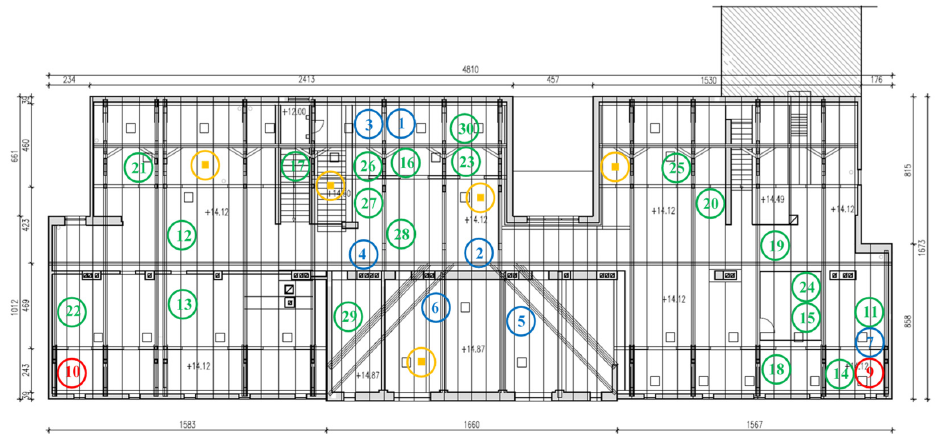
Figure 14. Probe positions and positions of damaged elements are shown in the construction plan.